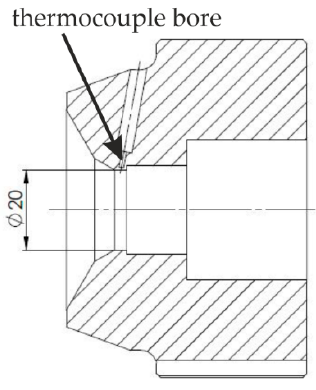
Figure 2. Sectional view of the die with thermocouple bore.